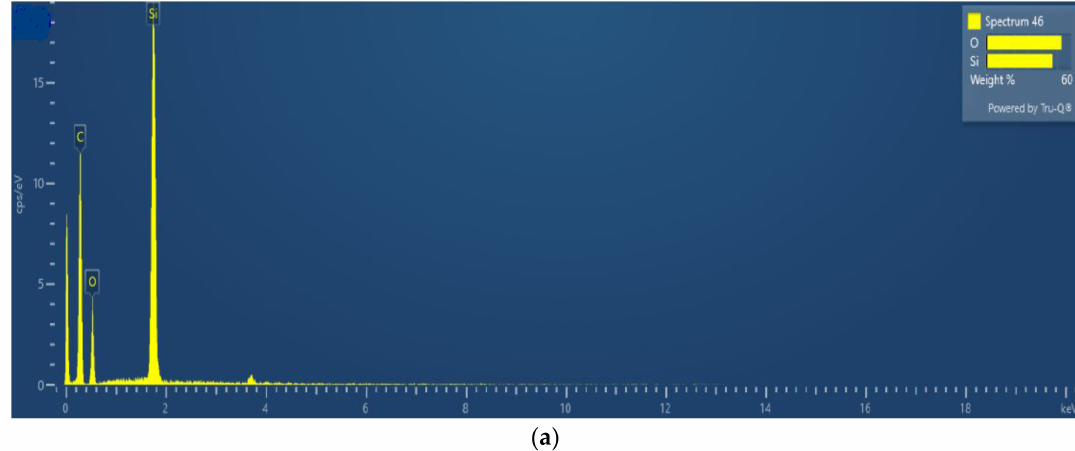
Figure 3. SEM microphotos taken for dental nanocomposite resins filled with 60 wt% of: ( a ) neat silica; ( b ) MPS; ( c ) OTMS; ( d ) ACPS; ( e ) MPS-OTMS; ( f ) ACPS-OTMS; and ( g ) MPS-ACPS-treated silica nanoparticles ( × 500